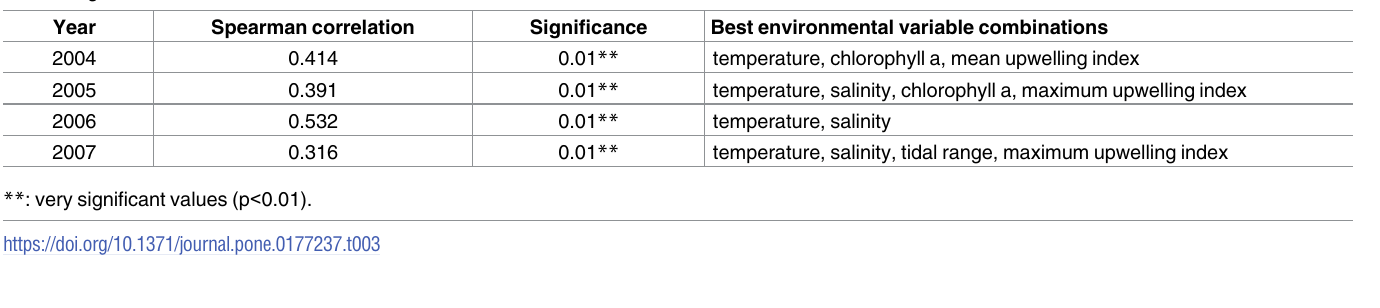
Table 3. Results of the BIO-ENV analysis showing the environmental variable combinations that yield the highest Spearmancorrelations with the biological data in each of the four yearsstudied. These combinations are the ones that better explainthe observed changesin the phytoplankton